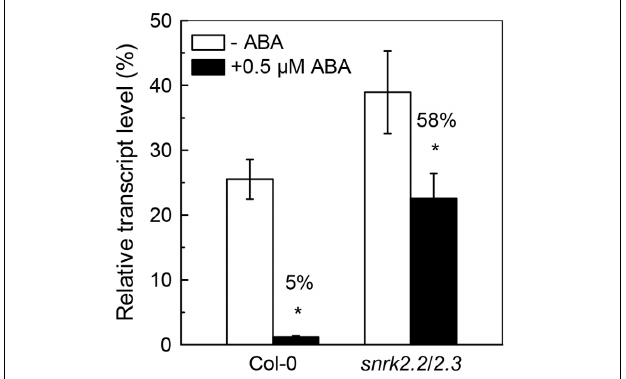
FIGURE 6 | Effect of ABA on expression of IRT1 in Col-0 and snrk2.2/2.3 plants. Plants were grown in 10 µ M Cd-added nutrient solution containing 0 or 0.5 µ M ABA for 3 days. The Fe level in the nutrient solution was 25 µ M. Transcript level of IRT1 was normalized to that of UBQ10 mRNA (100%). Data are means ± SD ( n = 6). ∗ Significant differences ( P < 0 . 05) between ABA-free and ABA-added treatments.